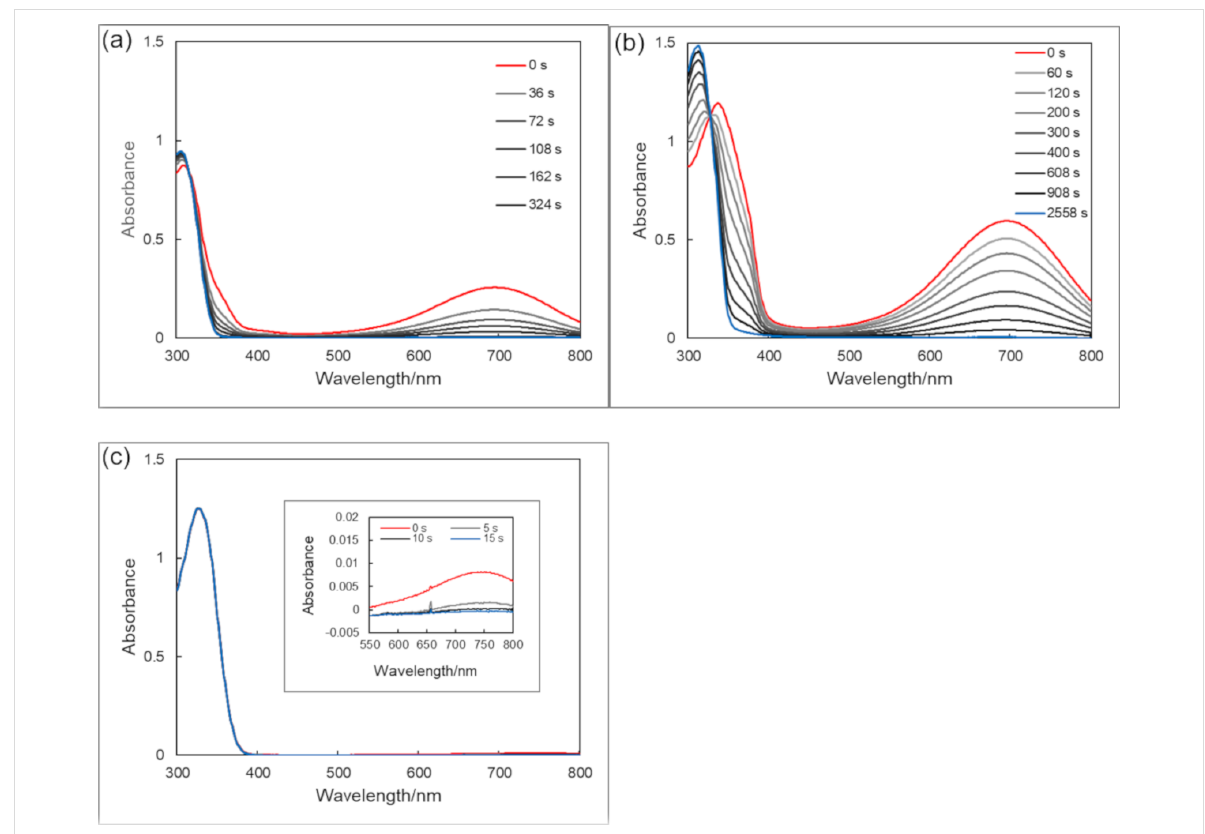
Figure 2: Absorption spectral change of triazoles 1c – 3c during the thermal back reaction after 313-nm light irradiation to 1o – 3o in MeCN at 28 °C. Concentration of compounds are the same as in Figure 1. (a) 1c . (b) 2c . (c) 3c .